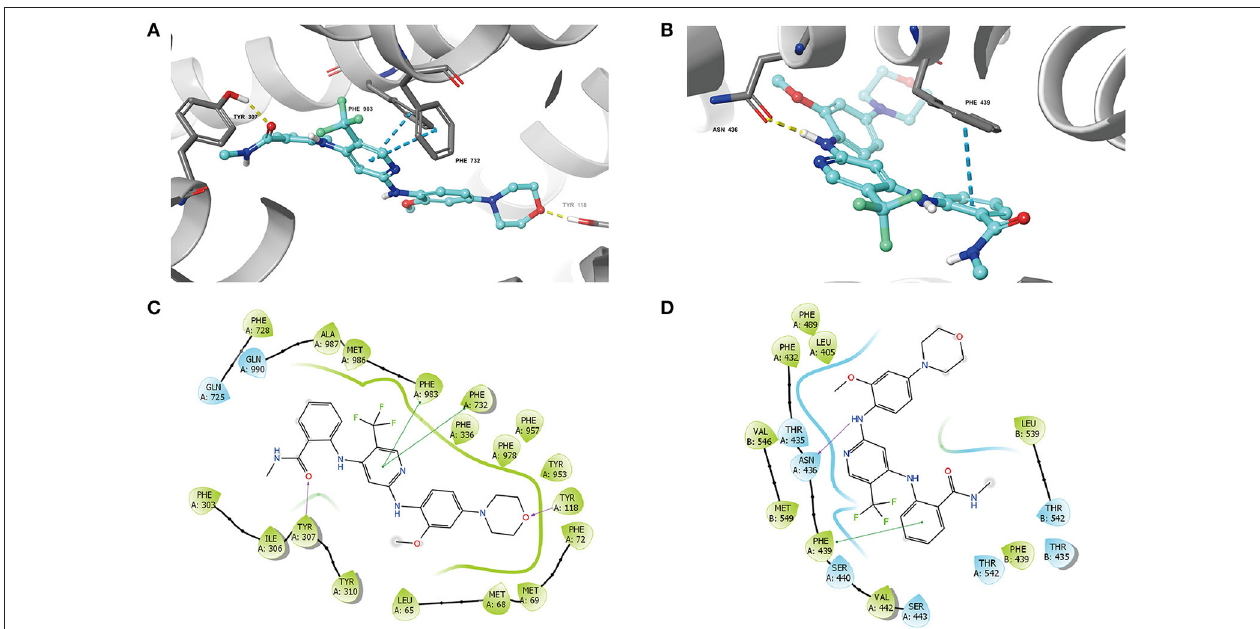
FIGURE 7 | The molecular modeling study of VS-4718 with human homology ABCB1 and human ABCG2 . (A) Docked position of VS-4718 within the drug-binding site of human ABCB1 homology model. (B) Docked position of VS-4718 within the binding site of ABCG2. VS-4718 is shown as ball and stick mode with the atoms colored: carbon-cyan, hydrogen-white, nitrogen-blue, oxygen-red, fluorine-green, hydrogen-white. Important residues are shown as sticks with gray color. π - π stacking interactions are indicated with cyan dotted short line. Hydrogen bonds are shown by the yellow dotted line. (C) The two-dimensional ligand-receptor interaction diagram of VS-4718 and human homology ABCB1. (D) The two-dimensional ligand-receptor interaction diagram of VS-4718 and human ABCG2. The amino acids within 3 Å are shown as colored bubbles, cyan indicates polar residues, and green indicates hydrophobic residues. The purple arrow indicates hydrogen bond and green short line shows π - π stacking